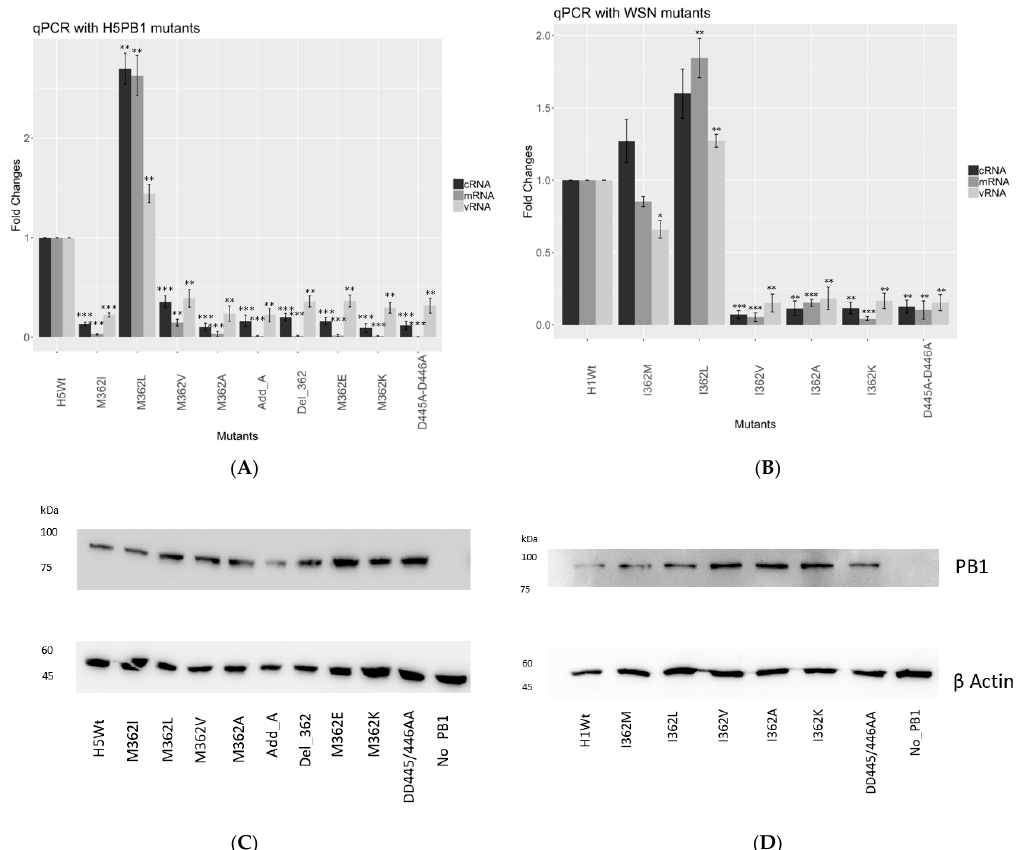
Figure 2. Quantitative PCR for the hydrophobic mutants. Effect of the mutants on the RNA synthesis pathways was determined by qPCR. Total RNA harvested 24 hours post-transfection was reverse transcribed by artificially tagged primers, with 5s rRNA as the internal control. qPCR was performed by the amplification between the tag and segment. ( A ) The relative RNA expression level of WSN PB1 mutants and ( B ) the relative RNA expression level of 156/97 PB1 mutants. Error bar showed the SEM of three independent experiments and statistical analysis was performed by Student’s t -test (* = p value < 0.05; ** = p value < 0.01; *** = p value < 0.001). Samples were probed by specific antibody against PB1 and β actin. Mutants of 156/97 PB1 ( C ) and WSN PB1 ( D ) showed similar expression levels after normalizing to the corresponding β actin control (Supplementary Figure